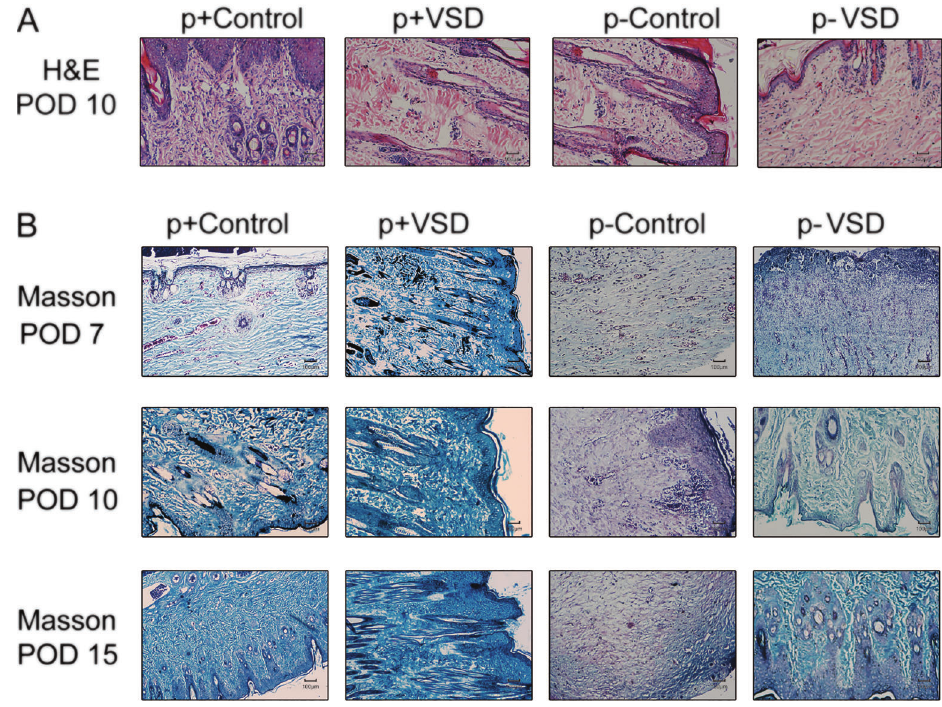
Figure 2. Histological observations of the wounds at different post-operative days (POD). A , Slides subjected to H&E staining. The vacuum sealing drainage (VSD)-treated groups had low levels of in fl ammatory cells in fi ltration. B , Collagen fi bers evaluated using Masson ’ s trichrome stain (magni fi cation (cid:1) 200). VSD-treated groups demonstrated greater collagen organization compared to the corresponding Control group at all time points. p + : periosteum-intact; p – :